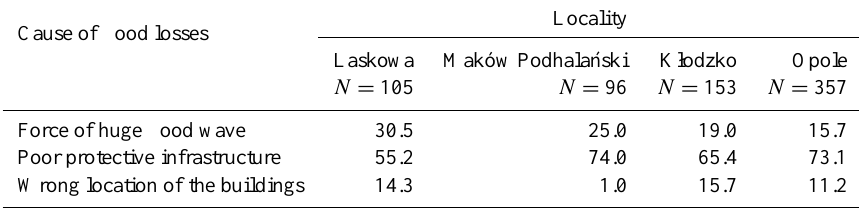
Table 4. Share of the respondents (%) identifying different main causes of flood